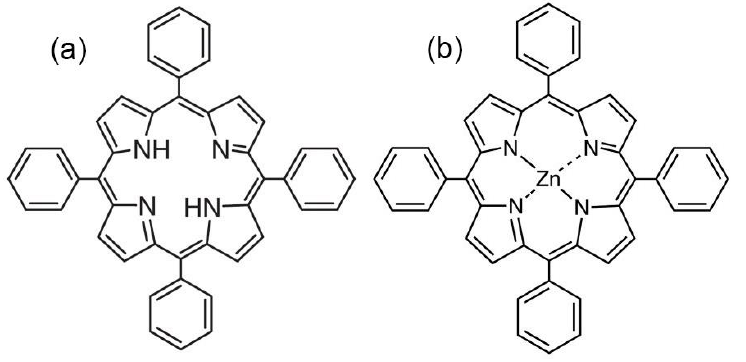
Figure 1. The structure of TPP ( a ) and ZnTPP ( b ).